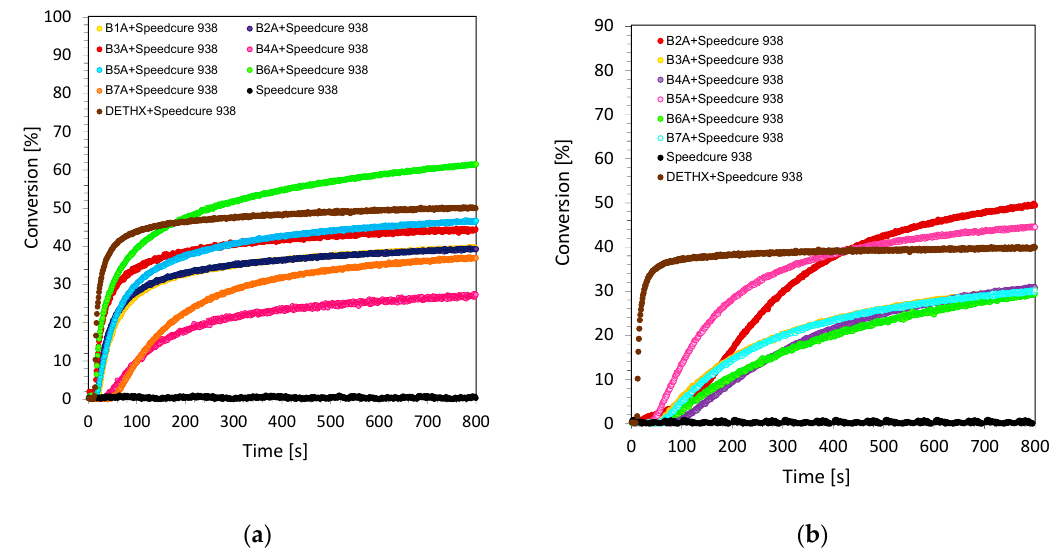
Figure 3. ( a ) Cationic photopolymerization profiles (epoxy function conversion vs. irradiation time) initiated by bimolecular photoinitiating system based on Speedcure 938 (1% wt.) and 2-amino-4-methyl- 6-(4-phenylphenyl)benzene-1,3-dicarbonitrile derivatives (0.1% wt.) for series 2 ( a ) under irradiation at 365 nm; ( b ) under irradiation at 405